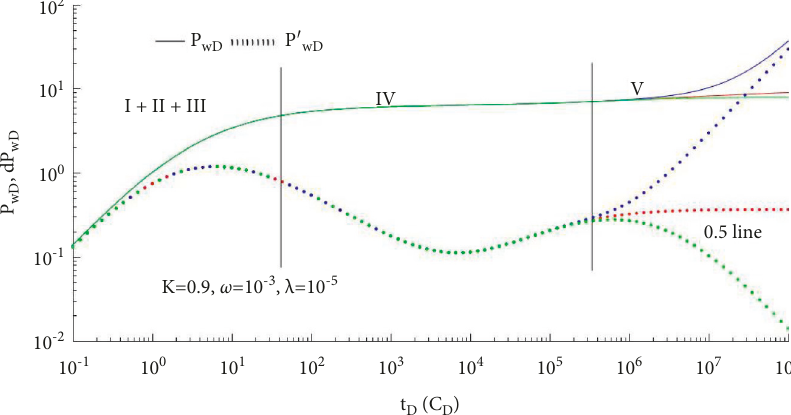
Figure 2: Special curves of the pressure and pressure derivative of dual permeability ( C